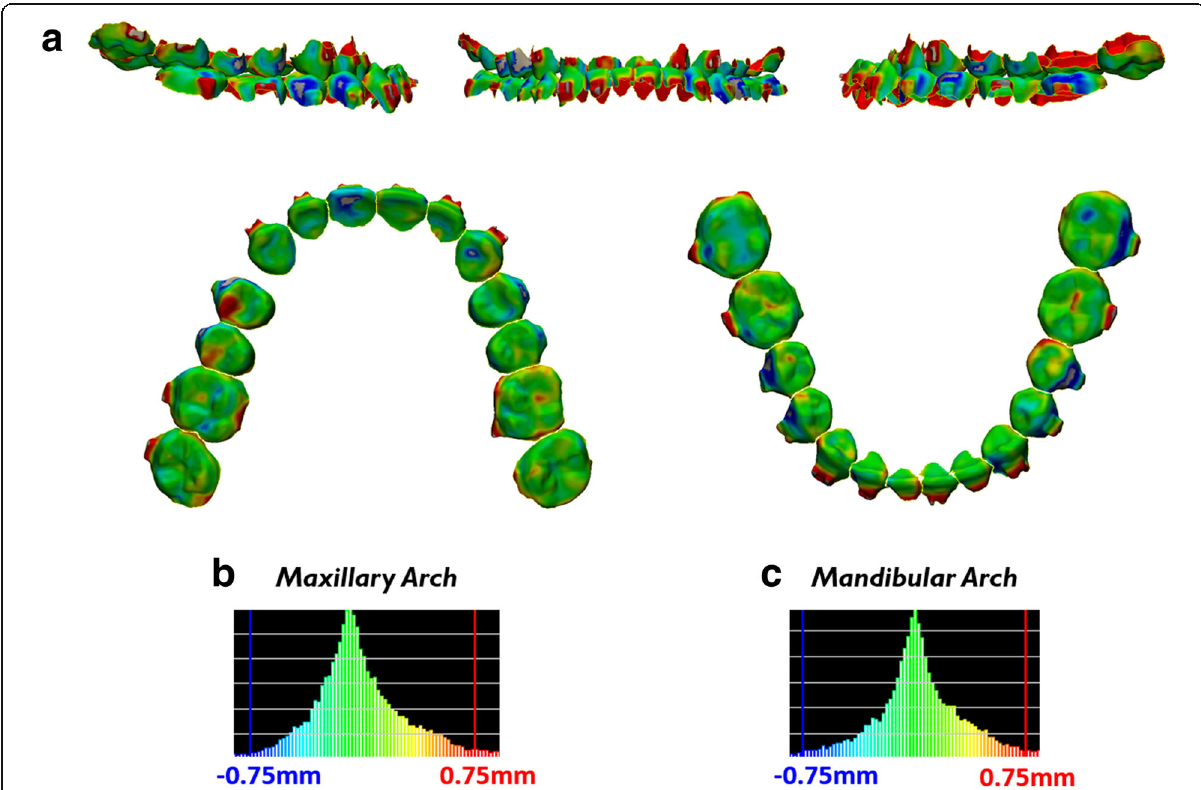
Fig. 4 Verification of accurate crown superimposition during ERP setup generation after direct superimposition between the crowns of the pre-treatment CBCT teeth and the reset appointment laser scan. a Color displacement maps comparing the crown positions of the pre-treatment CBCT crowns and reset appointment laser scan crowns. Green areas indicate 0.0 mm displacement; blue and red areas indicate equal to or greater than 0.75 mm. b , c Histograms showing the distribution of displacements between crowns of the pre-treatment CBCT scan and reset